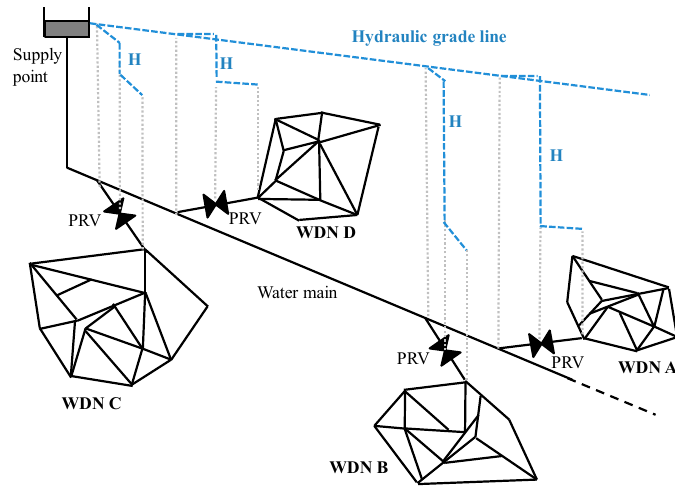
Figure 3. Layout of the four water distribution networks (WDNs).